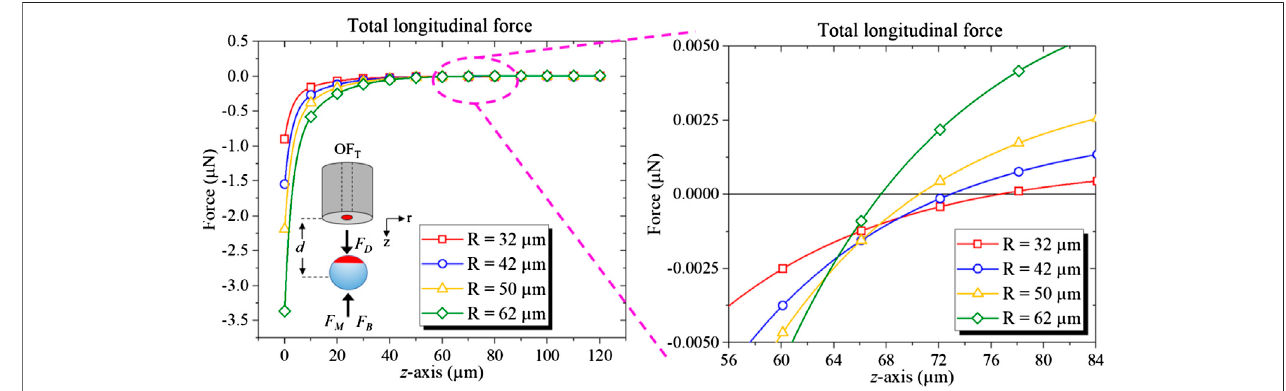
FIGURE8| Totallongitudinalforceusing Eq.7 formicrobubblewithradii ∼ 32, ∼ 42, ∼ 50,and ∼ 62 µm.Thezerocrossingdisplacestothesmallerdistances z asthe convective current increases as discussed in the main text.